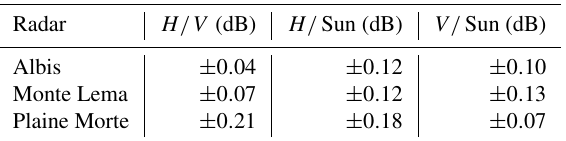
Table B1. Standard deviation of the error, with the Sun radiation as a reference, without noise